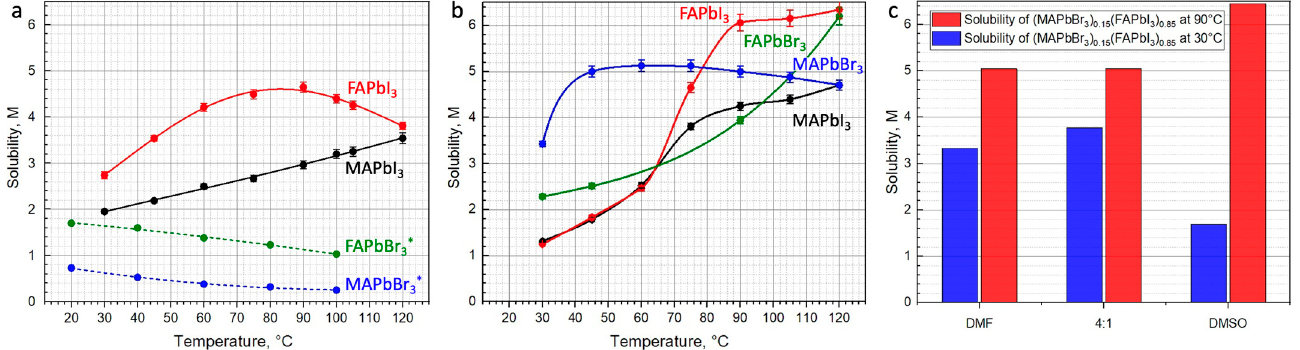
Figure 1. Solubility of hybrid perovskites of different compositions in DMF ( a ) and DMSO ( b ) within the range of 30–120 °C. Solubility of (MAPbBr 3 ) 0.15 (FAPbI 3 ) 0.85 at 30 °C and 90 °C in DMF, DMSO and DMF/DMSO (4:1 v / v ) mixture ( c ). * Data on FAPbBr 3 and MAPbBr 3 solubilities showed by dashed lines are determined by M. Saidaminov et al. [7]. Table 1. Solubility behavior of hybrid perovskite depending on the solution composition.